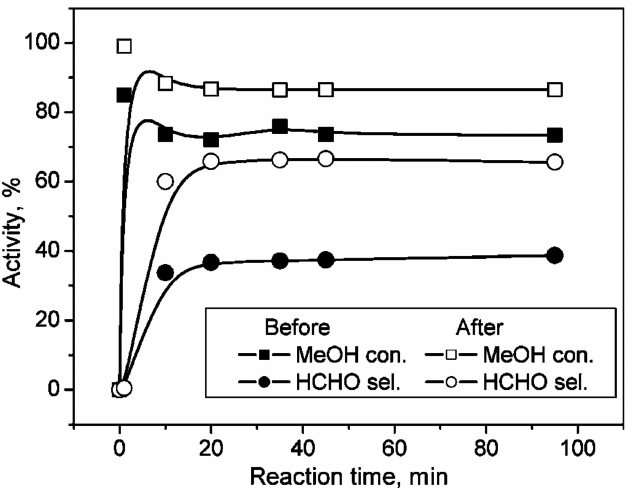
Figure 23. Activity of a Mo 0.65 V 0.25 W 0.10 mixed oxide catalyst as function of reaction time at 350 ◦ C before and after heat treatment at 540 ◦ C for 2 h in N 2 . Feed: O 2 /CH 3 OH = 1.47. Reprinted with permission from [135] Springer, Catalysis Letters, Copyright ©